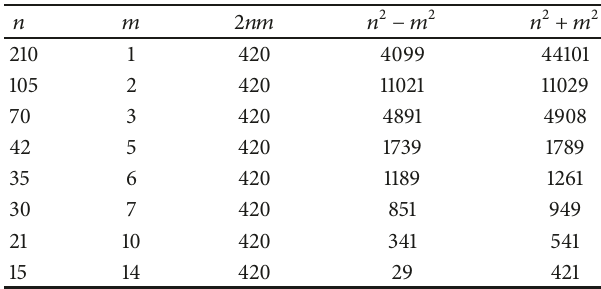
Table 5: Primitive Pythagorean triples with common leg 𝑎 = 420